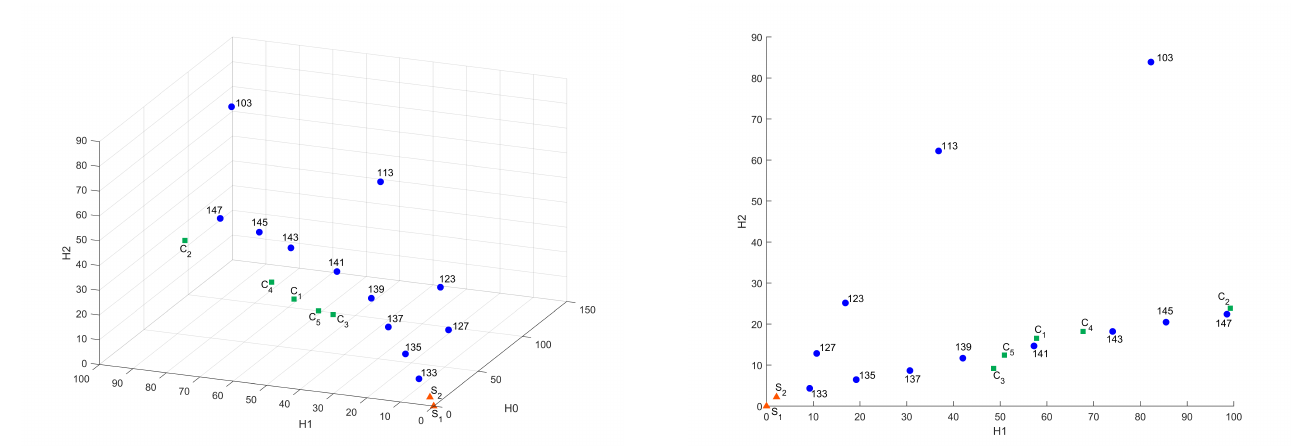
Figure 9. Influence of the binarization threshold of A sample in Bottleneck metric in 3D and H 0 – H 1 coordinates.